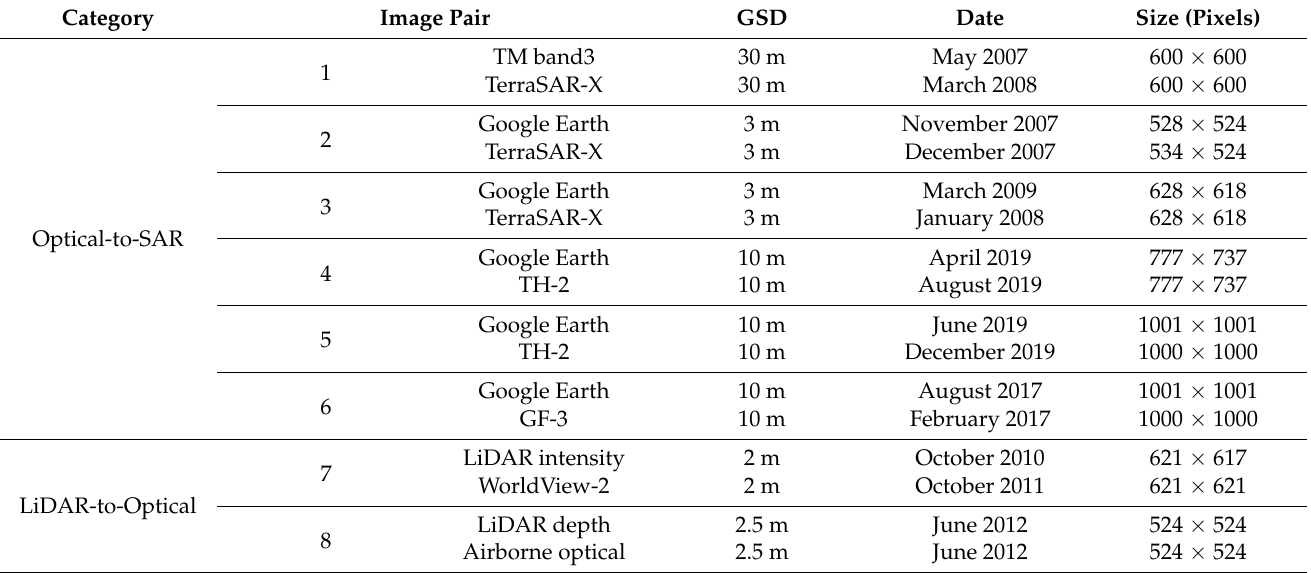
Table 1. The detailed information of all experimental image pairs used in Section